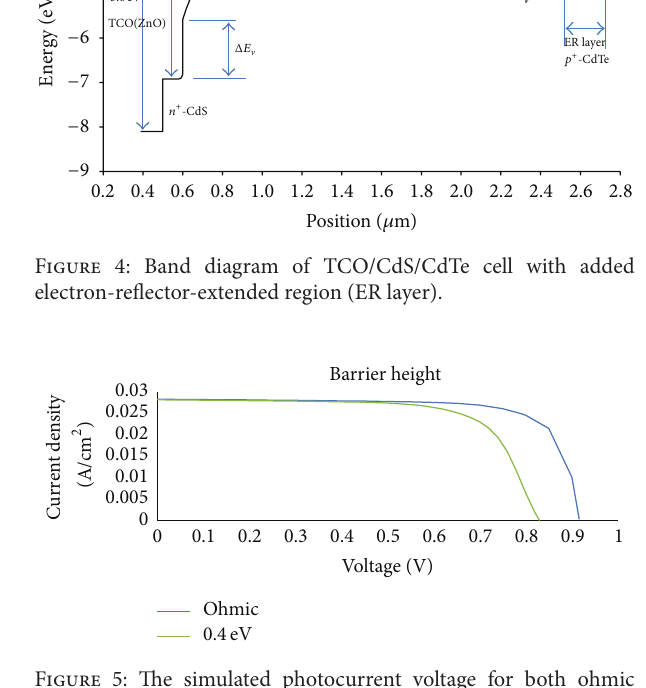
Figure 5: The simulated photocurrent voltage for both ohmic contact and Schottky contact with a barrier height ( 𝜑 e) of 0.4eV. No extended region is